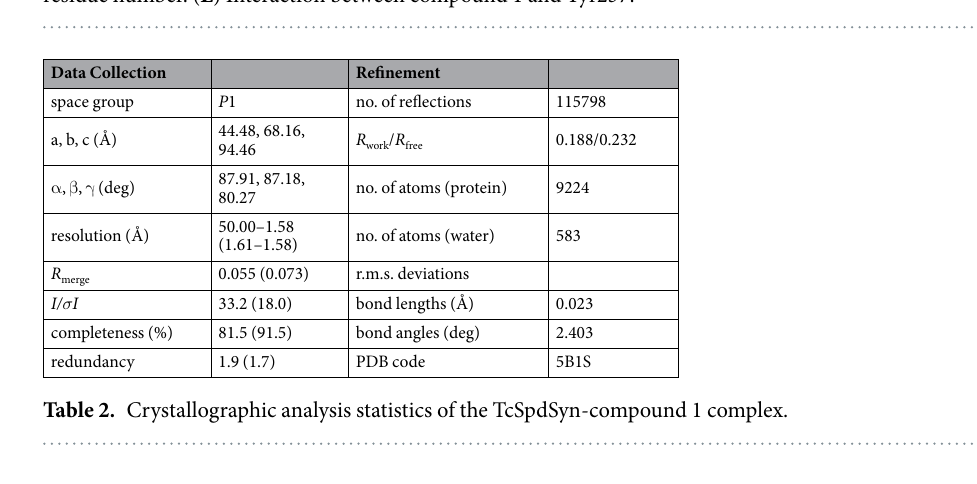
Figure 3. The crystal structure analysis of TcSpdSyn with compound 1. ( A ) The crystal structure of the TcSpdSyn-compound 1 complex. ( B ) Binding form of compound 1 predicted by docking simulation. ( C ) Stereo representation of the TcSpdSyn-compound 1 complex structure. The 2 F o- F c map around compound 1 is shown as a blue mesh (contoured at 1.5 σ ). ( D ) Interaction energy analysis of compound 1. The vertical axis shows the interaction energy (kcal/mol) between the ligand and amino acid, and the horizontal axis shows the amino acid residue number. ( E ) Interaction between compound 1 and Tyr237.